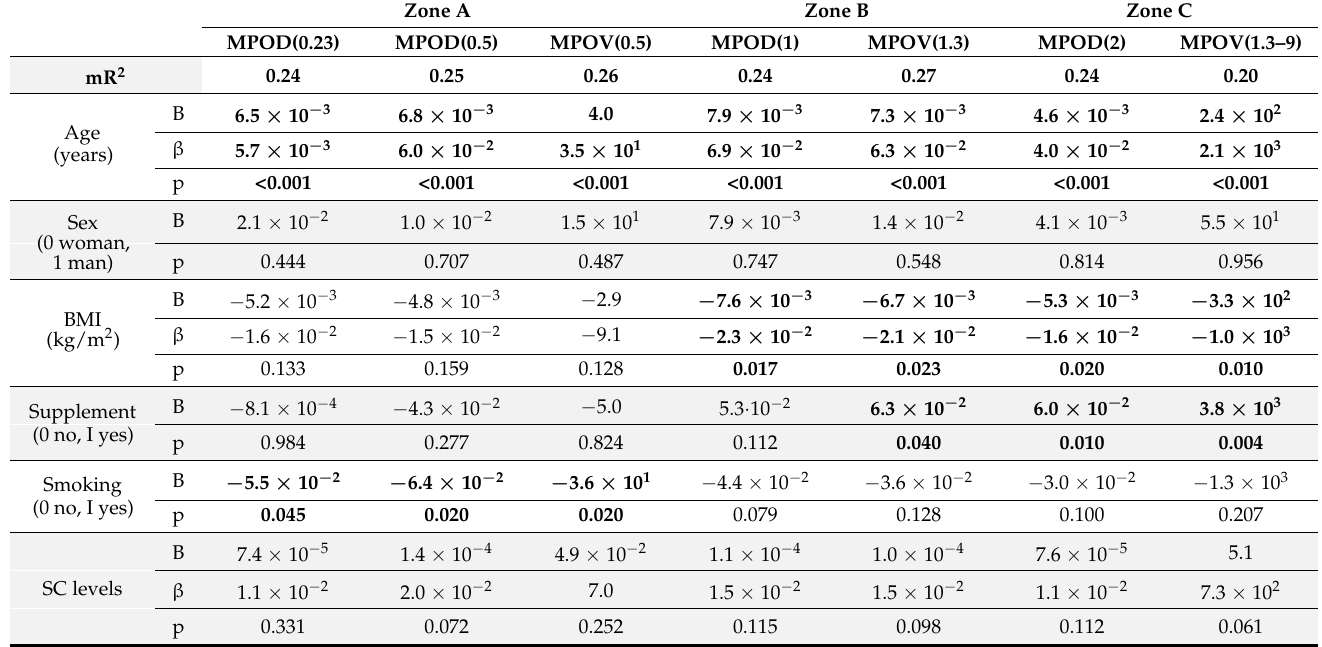
Table 4. Multiple regression analysis for MPOD and MPOV classified into three